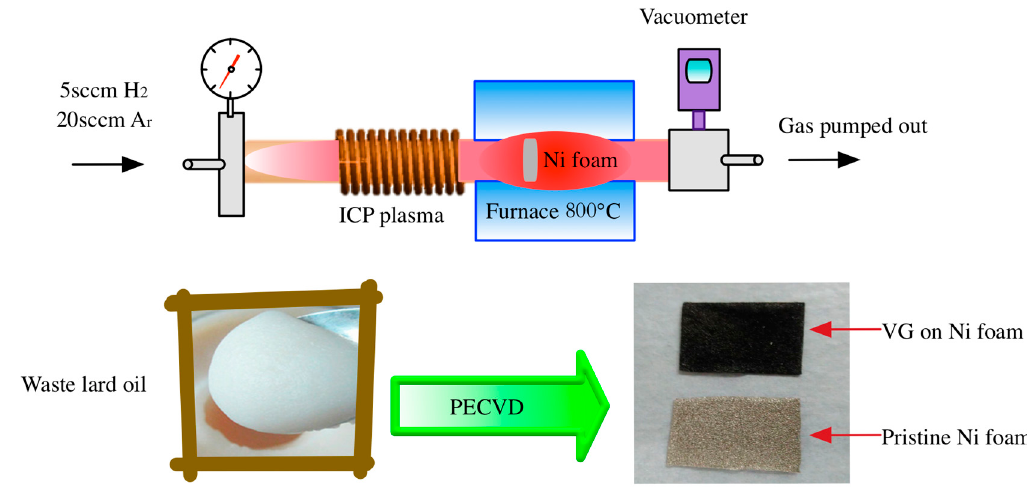
Figure 1. Schematic diagram of inductively coupled plasma-enhanced chemical vapor deposition (ICP-PECVD) applied for the synthesis of waste lard oil-based vertical graphene.